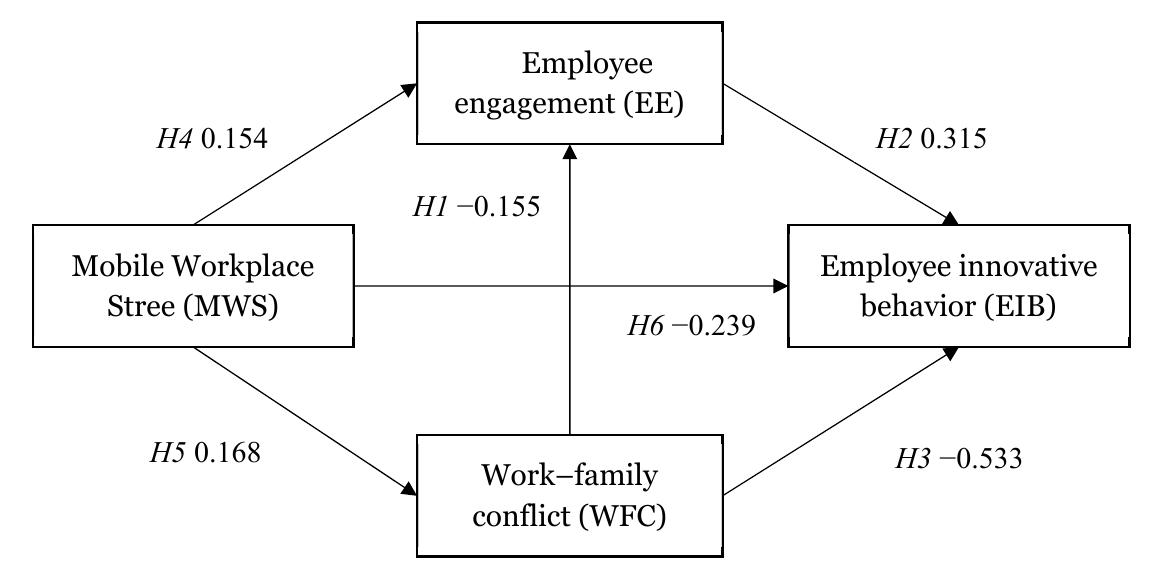
Figure 1. Results of structural equation model analysis. Table 4. Results of hypothesis testing through structural equation modeling.